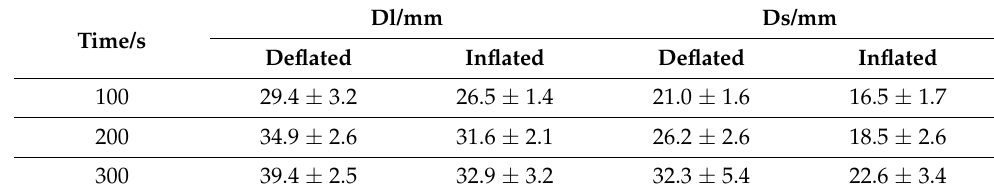
Table 7. Experimental data (ablation power 60